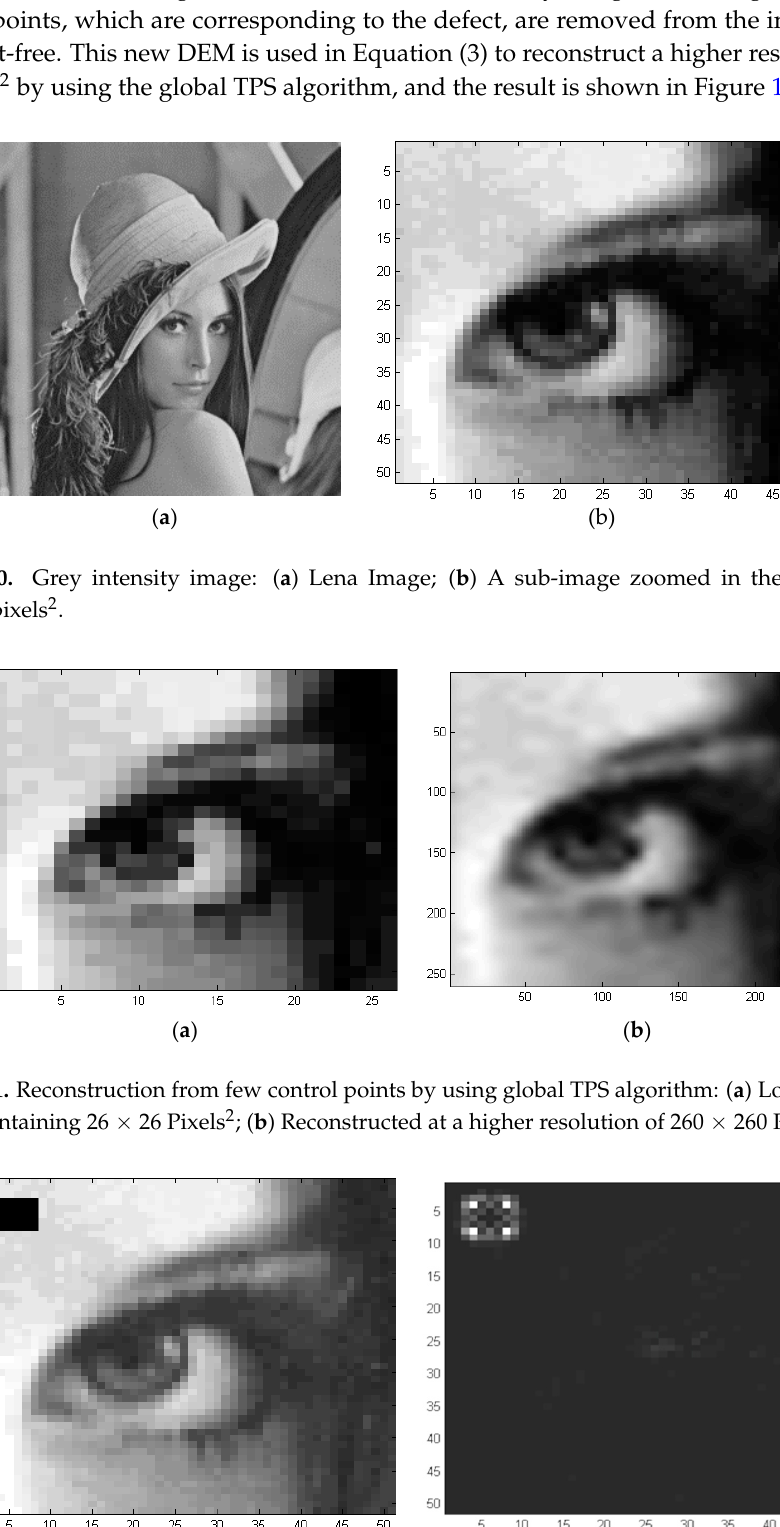
Figure 12. Detection of defects: ( a ) Defected image; ( b ) Defect detection by using the bending energy algorithm.